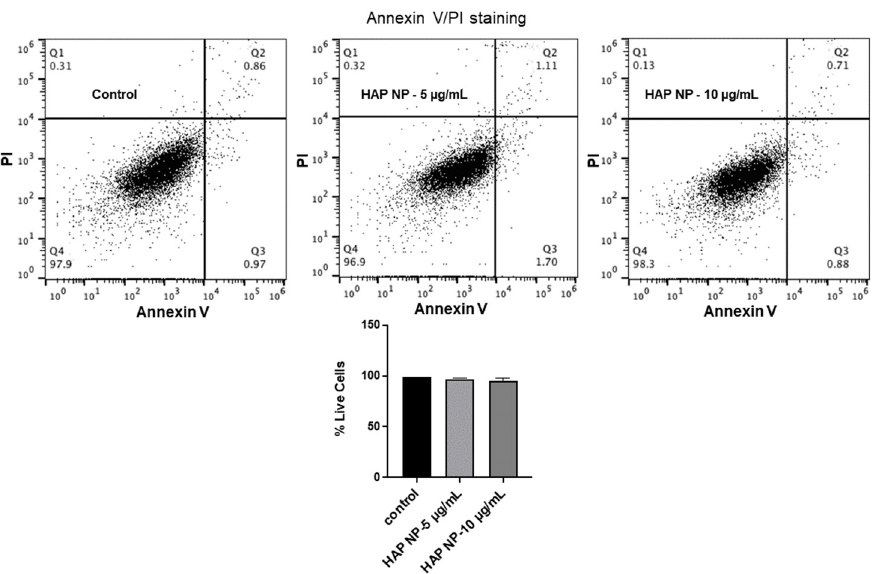
Figure 4. FACS analysis of HAP NP-induced cell death. To assess if HAP NP treatment induced toxicity and subsequent cell death, hBMVEC was treated with plasmin nanoparticles for 48 h and then stained with Annexin V FITC and PI as markers for apoptosis and necrosis and processed for FACs analysis. The four quadrants in the plots represent live cells (Q4), necrotic or late apoptotic (Q1), apoptotic cells (Q3), and dead cells (Q2). Percentage of live cells were obtained and plotted. n = 3 + SEM.